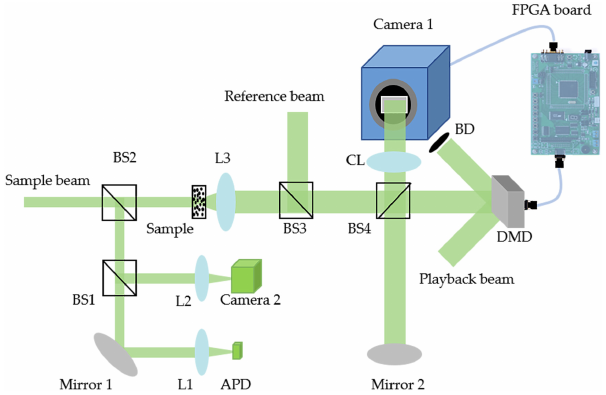
Fig. 3. A simpli¯ed schematic of the DMD-based DOPC. The scattered sample beam interferes with the reference beam and interference images are captured by Camera 1. The DMD and Camera 1 are aligned pixel-to-pixel and they are connected through a host FPGA. (L is lens; BS is beam splitter; BD is beam dump; CL is camera lens; APD is avalanche